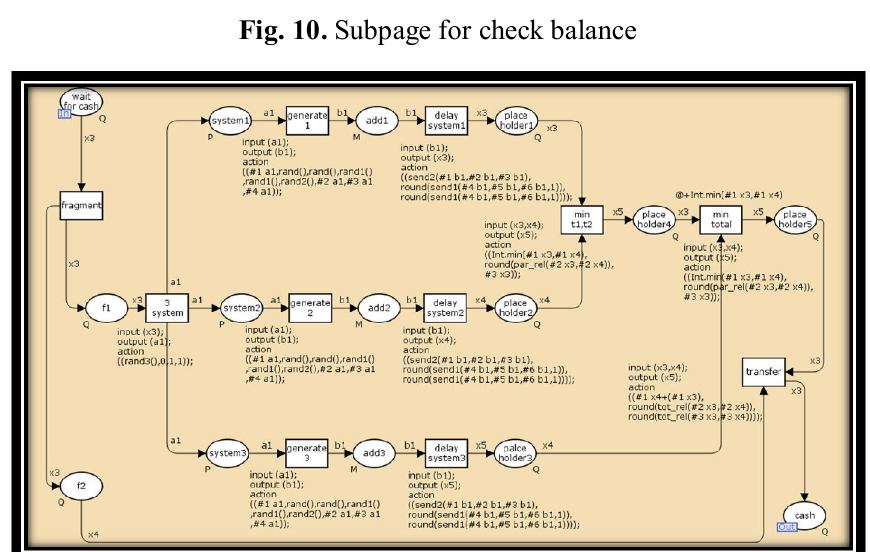
Fig. 11. Subpage for Pick